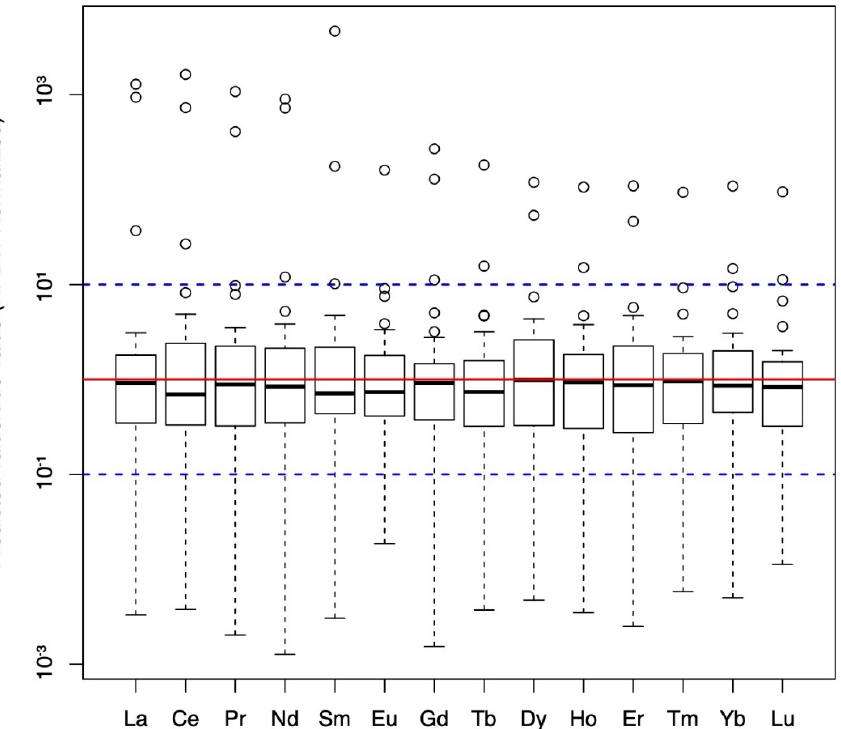
Figure 5. Prediction results for REEs in the cross ‐ validation dataset based only from major ions ( z 23 to z 29 ) and reservoir temperature. Upper and lower boundaries of each box denote the 3rd and 1st quartiles, respectively, thick black line denotes median, and whiskers are drawn out to 1.5 times the interquartile range beyond the 3rd and 1st quartiles. Circles indicate values beyond the whiskers. Red line ( y = 1) indicates perfect prediction and blue dashed lines ( y = 0.1, 10) indicate under ‐ and over ‐ prediction of NPDW ‐ normalized data by an order of magnitude, respectively.